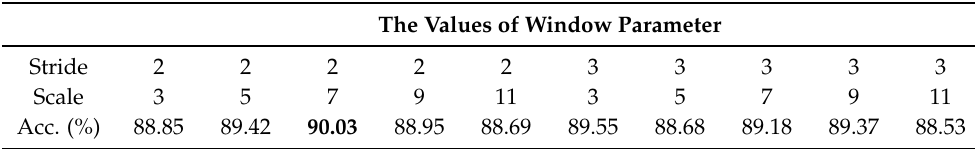
Table 2. Evaluation of the effects of different scale and stride values on the RAF-DB dataset. When using scale = 7 and stride = 2, the performance is the